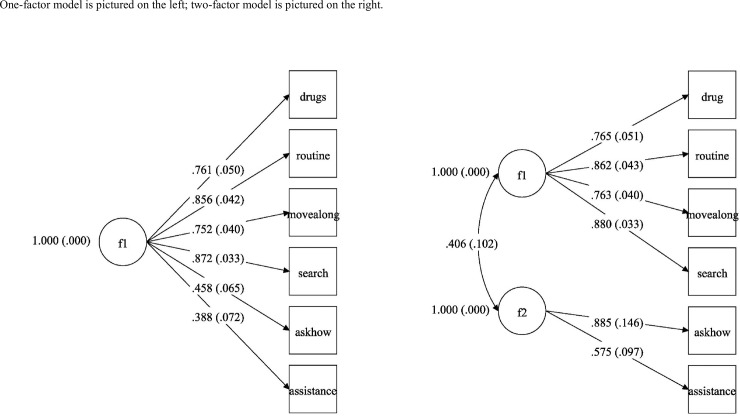
Factor loadings, standard errors and factor covariance from confirmatory factor analysis of the 6-item PPS.One-factor model is pictured on the left; two-factor model is pictured on the right.